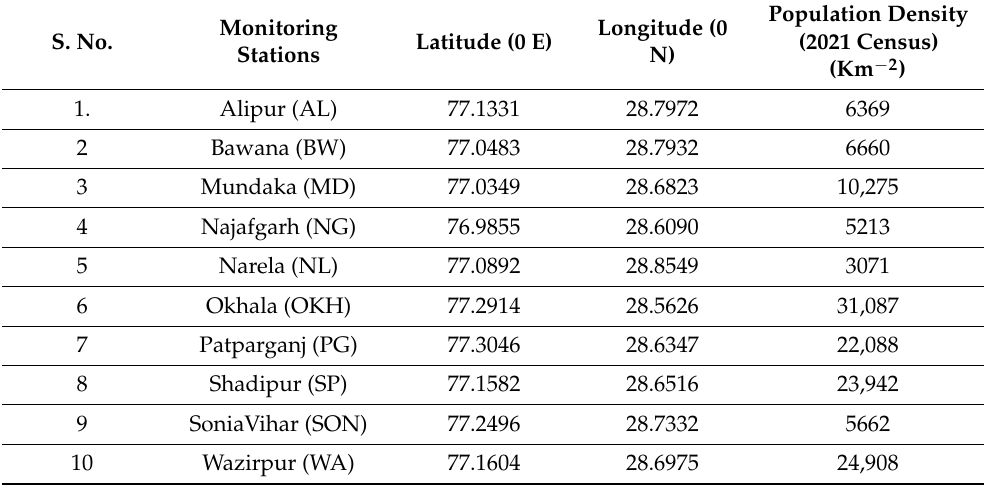
Table 1. Different monitoring stations with latitude, longitude, and population census at Delhi.